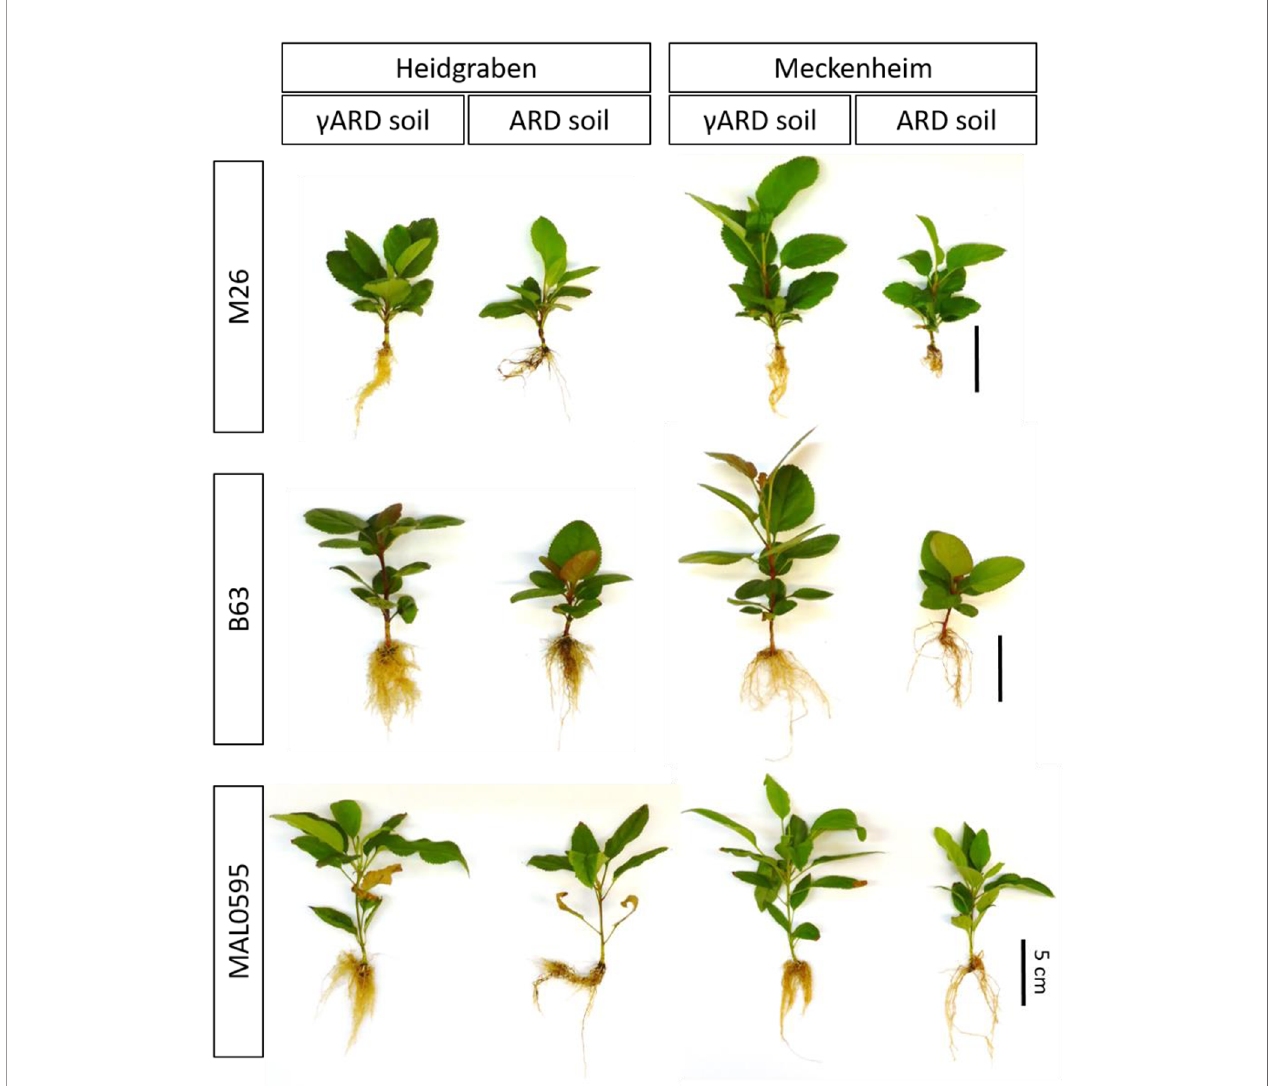
FIGURE 1 | Apple plants of M26, B63 and MAL0595 4 weeks after planting to g -irradiated apple replant disease ( g ARD) soil and ARD soil from the sites Heidgraben and